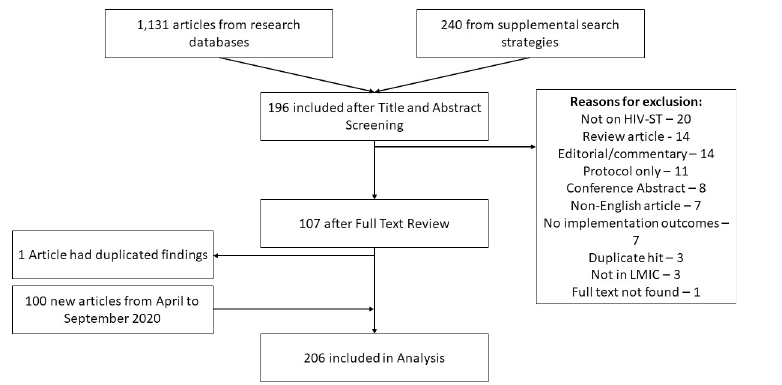
Fig 1. Flowchart of search. Notes: HIV-ST–HIV self-testing, LMIC–low- and middle-income country.